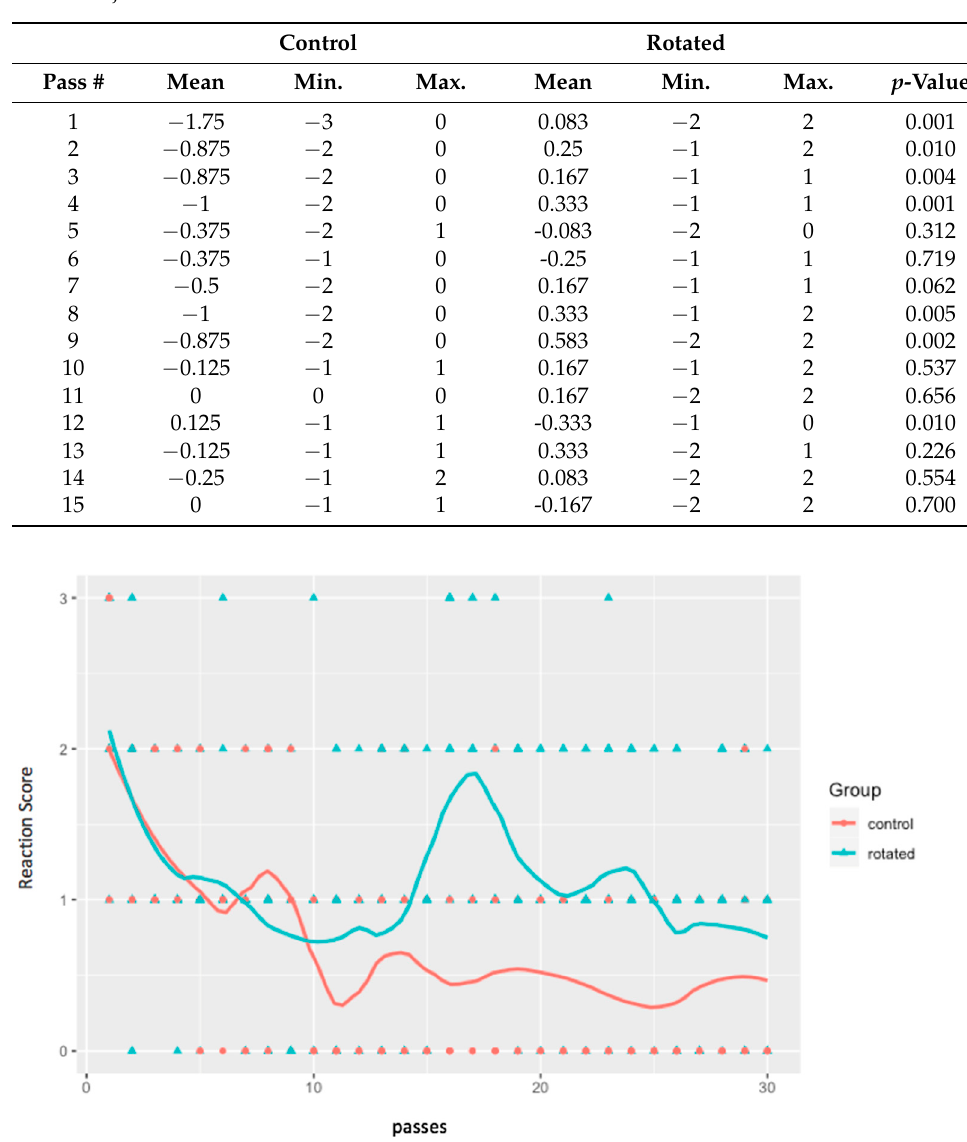
Figure 3. Graph of reaction scores from pass 1–30 for the control and rotated groups. The colored triangles indicate individual horses’ reactivity scores. The colored lines depict mean reaction score by group over passes (control = red, rotated = blue).